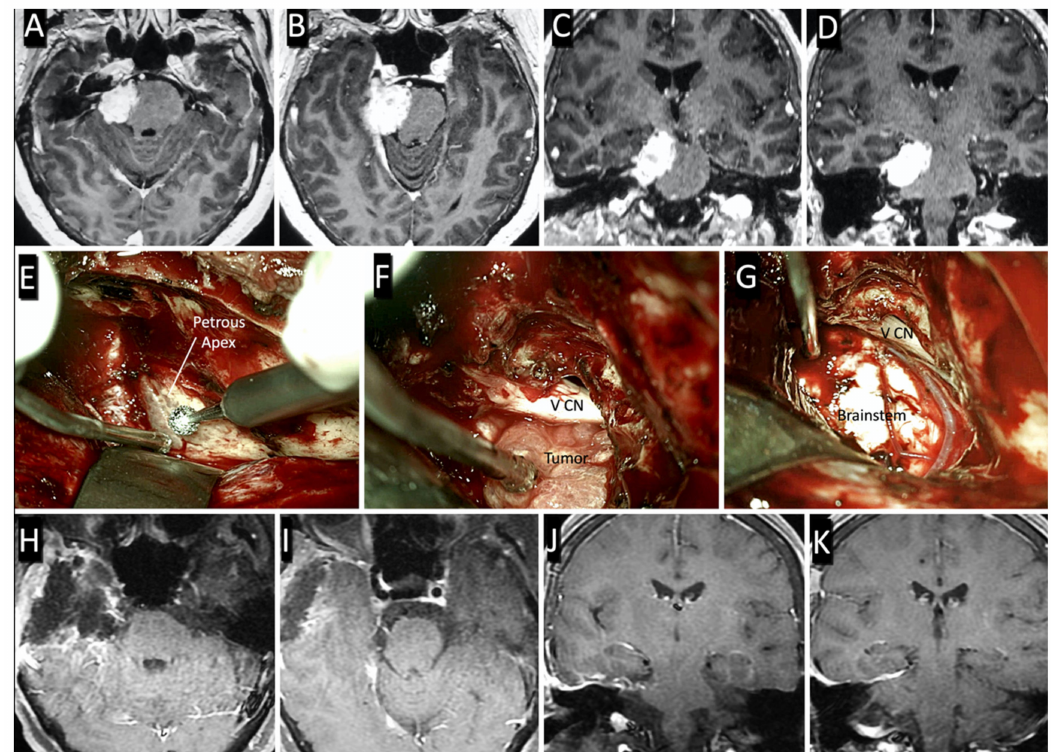
Figure 5. Preoperative axial ( A , B ) and coronal ( C , D ) T1-weighed contrast-enhanced MRI showing the petroclival menin- gioma. ( E – G ) Main steps of the anterior petrosal approach. ( E ) Peeling of the middle fossa dura and exposure of the petrous apex. ( F ) Intradural tumor exposure and initial debulking. ( G ) Surgical field after tumor resection and visualization of the lateral aspect of the pons. Postoperative axial ( H , I ) and coronal ( J , K ) contrast-enhanced T1-weighed MRI showing the gross total resection of the tumor (Simpson grade